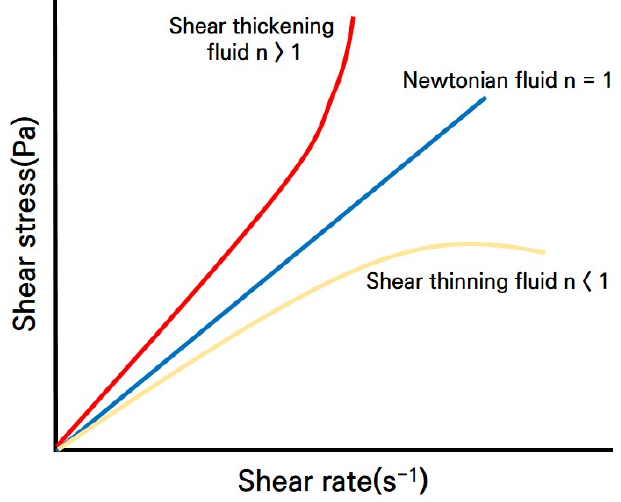
Figure 1. Schematic graph of the shear thickening mechanism of STF.